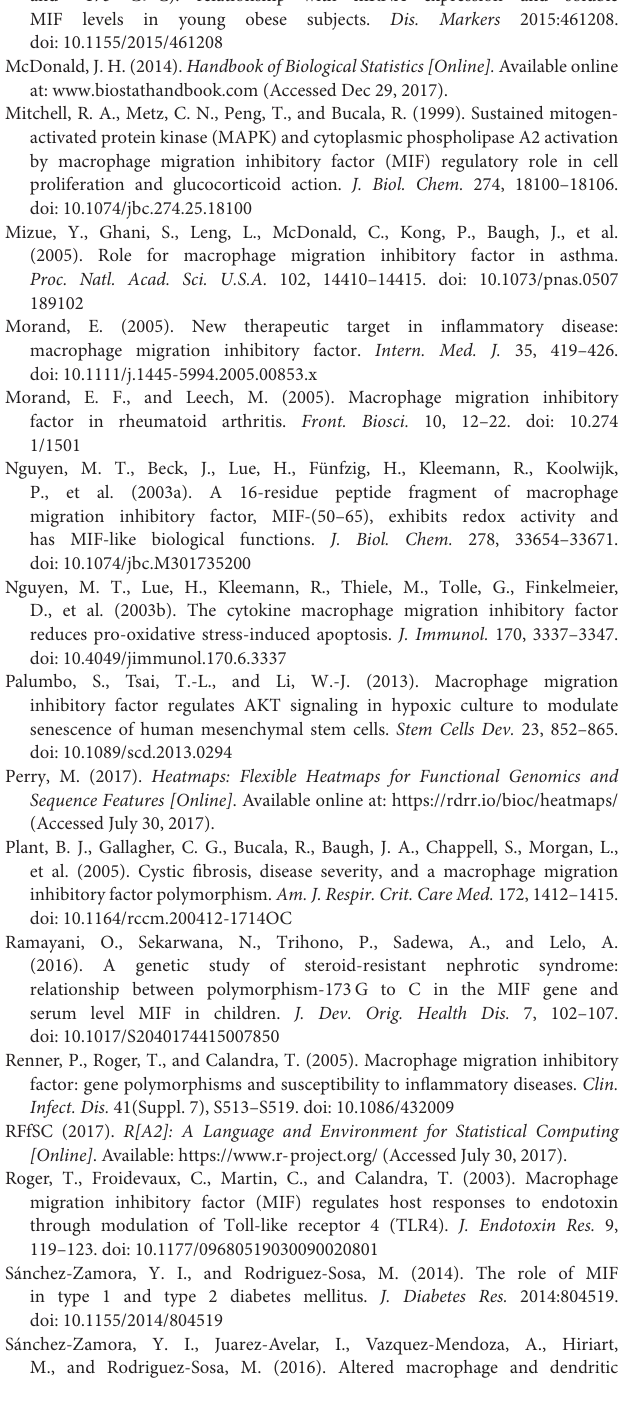
Frontiers in Genetics |